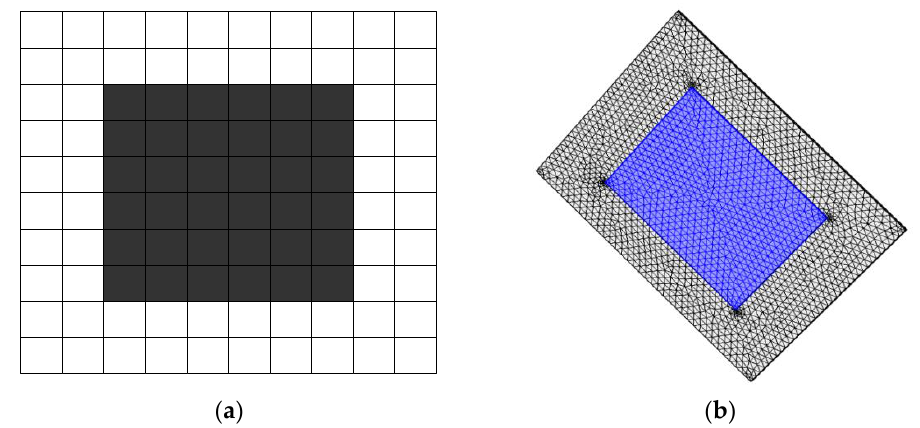
Figure 5. The unit cell of configuration A: ( a ) configuration A and ( b ) its FEM.